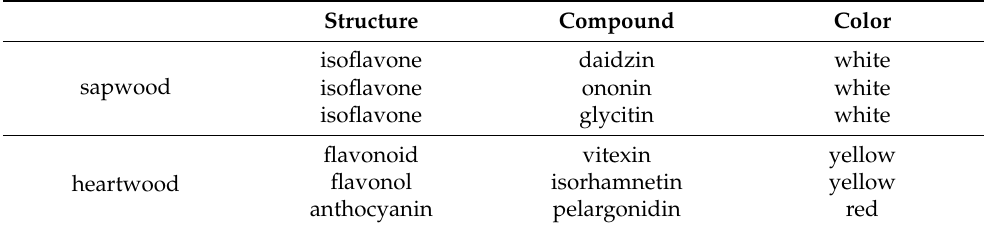
Table 3. Different chemical constituents between D. oliveri heartwood and sapwood.